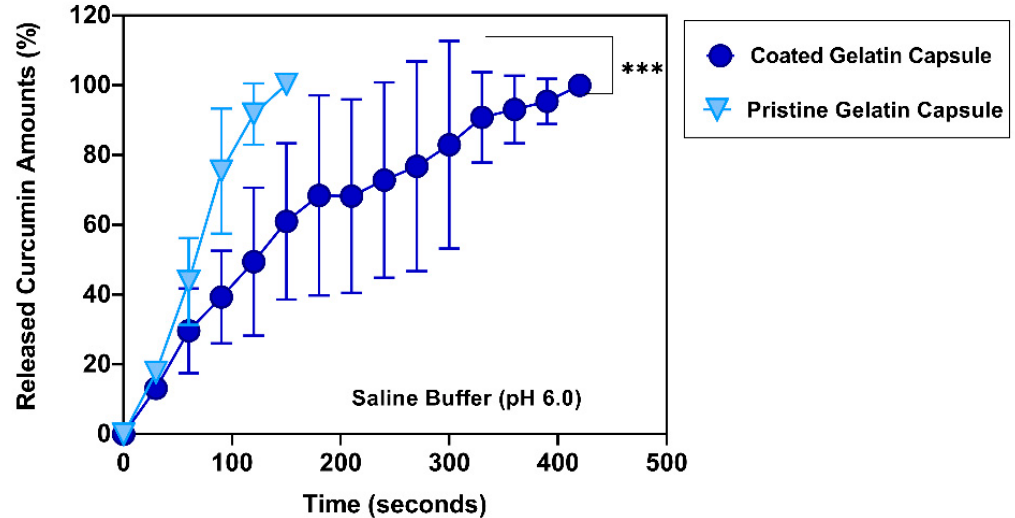
Figure 7. Accumulated curcumin release profiles from different gelatin capsules over time at pH 6.0. Significantly delayed release of curcumin over 7 minutes (420 s) was observed from EA doped enteric-coated gelatin capsules (n = 3 in each condition). ***: p < 0.001.